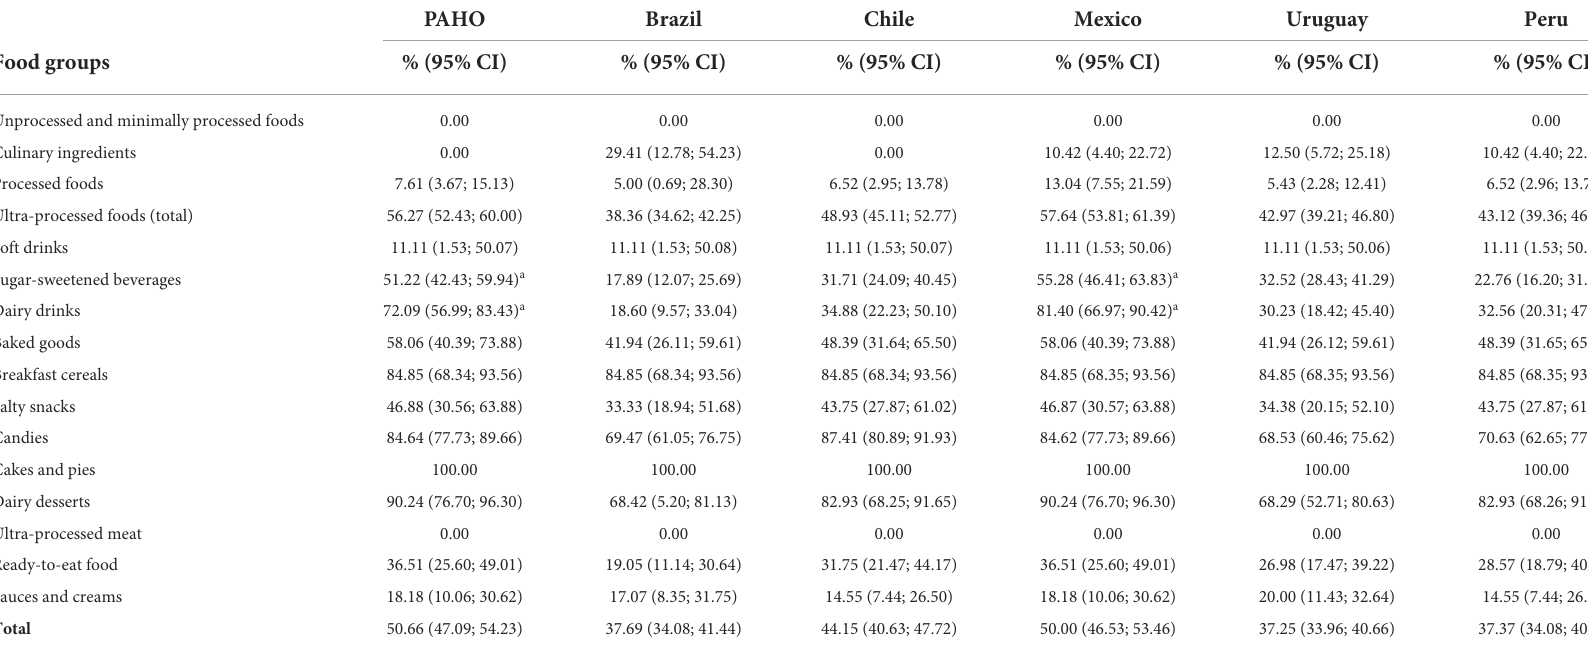
TABLE 6 Proportion (%) of foods and beverages with child-directed marketing and high content of free sugar according to different nutrient profile models (NPMs), overall, and by food category (Brazil, 2017).